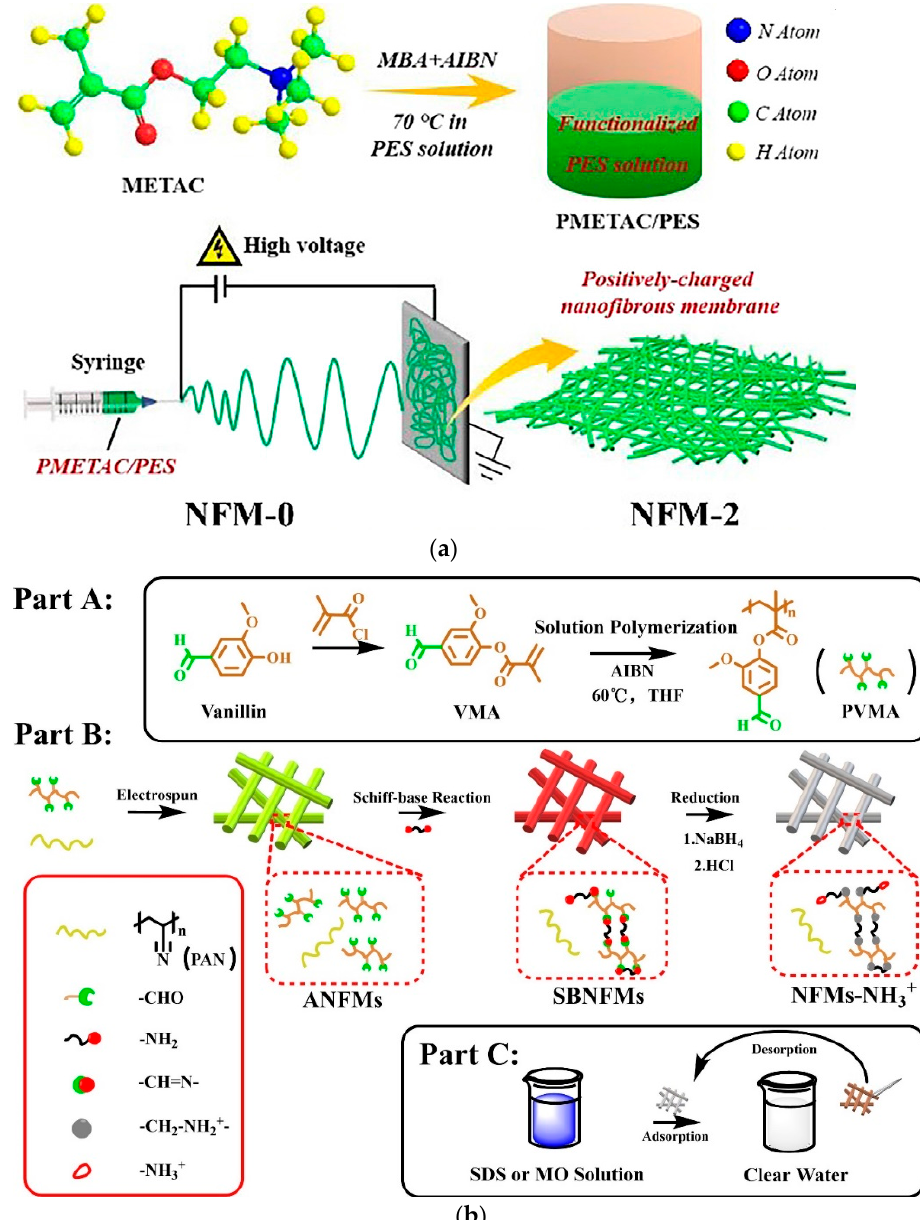
Figure 2. Schematic illustration of ( a ) the electrospinning of the solution and the fabrication of positively charged PES NFMs (reproduced from [75] with permission of Elsevier, 2019), and ( b ) the production of the polymer (PVMA) starting from the bio-based monomer vanillin (Part 1); creating a functional membrane by sequential reactions with ethylenediamine, sodium borohydride and HCl (Part 2); and the removal of SDS and MO via the membranes (Part 3) (reproduced from [78] with permission of Elsevier, 2020).